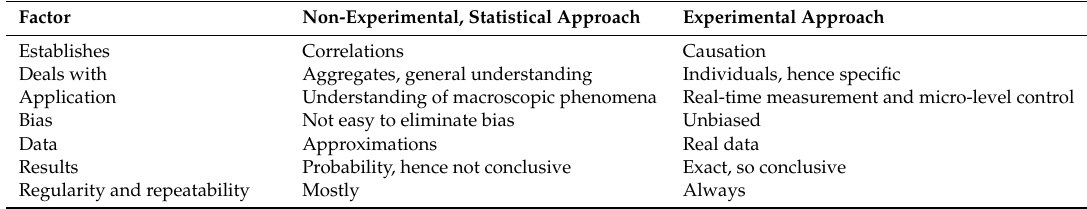
Table 1. Comparison between traditional non-deterministic Non-Intrusive Load Monitoring (NILM) methods versus proposed deterministic